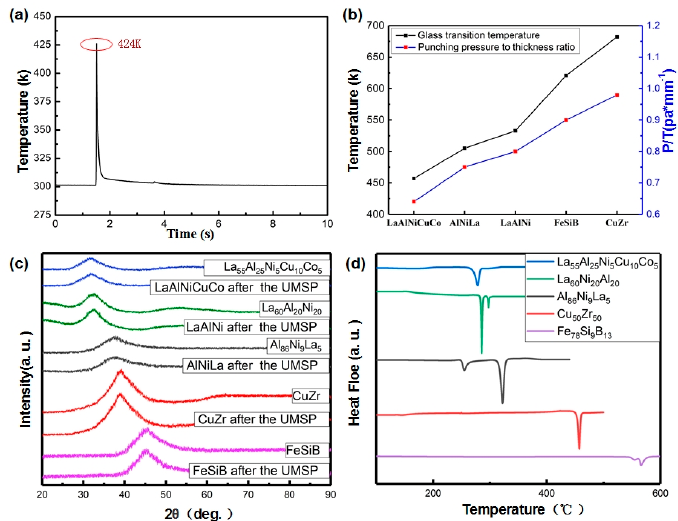
Figure 3. ( a ) The real-time temperature of plastic powder. ( b ) The di ffi culty of punching successfully of several matrix amorphous alloys in shear punching of amorphous alloys under high-frequency vibration ( c ) The X-ray di ff raction (XRD) pattern of amorphous alloys before and after shear punching of amorphous alloys under high frequency vibration. ( d ) The di ff erential scanning calorimetry (DSC) curve of amorphous